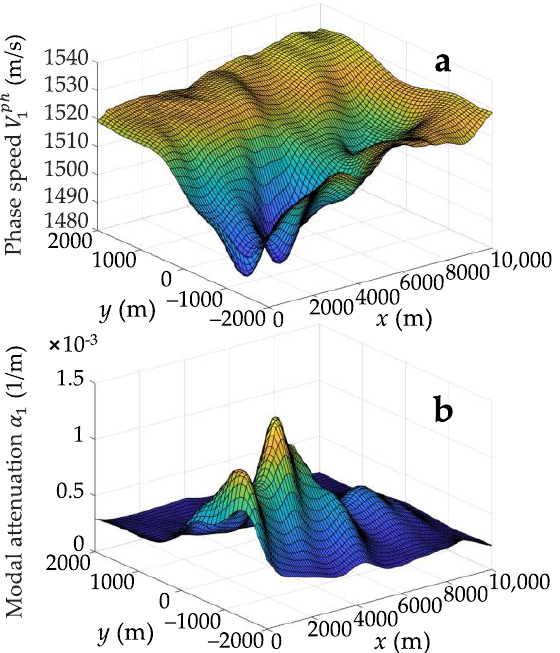
Figure 6. Spatial distributions of ( a ) the phase speed 𝑉 𝑙𝑝ℎ and ( b ) attenuation coefficient 𝛼 𝑙 of the first mode at a frequency of 55 Hz in the selected region of the Kara Sea.